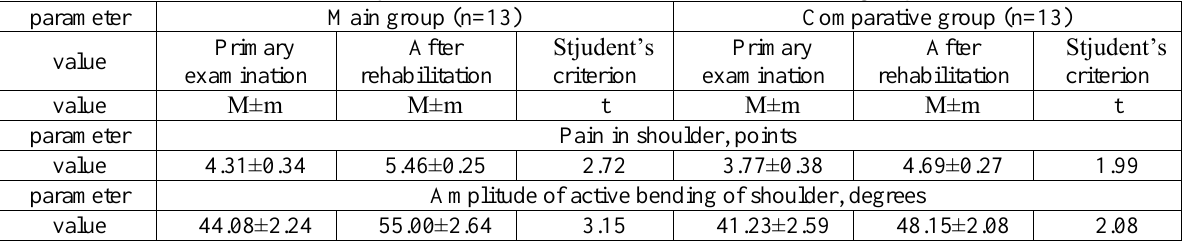
Dynamic of tested indicators of main and control